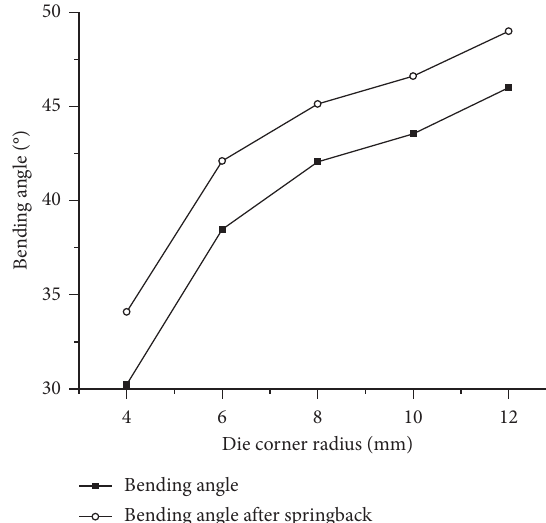
Figure 22: Curves of equivalent plastic strain after